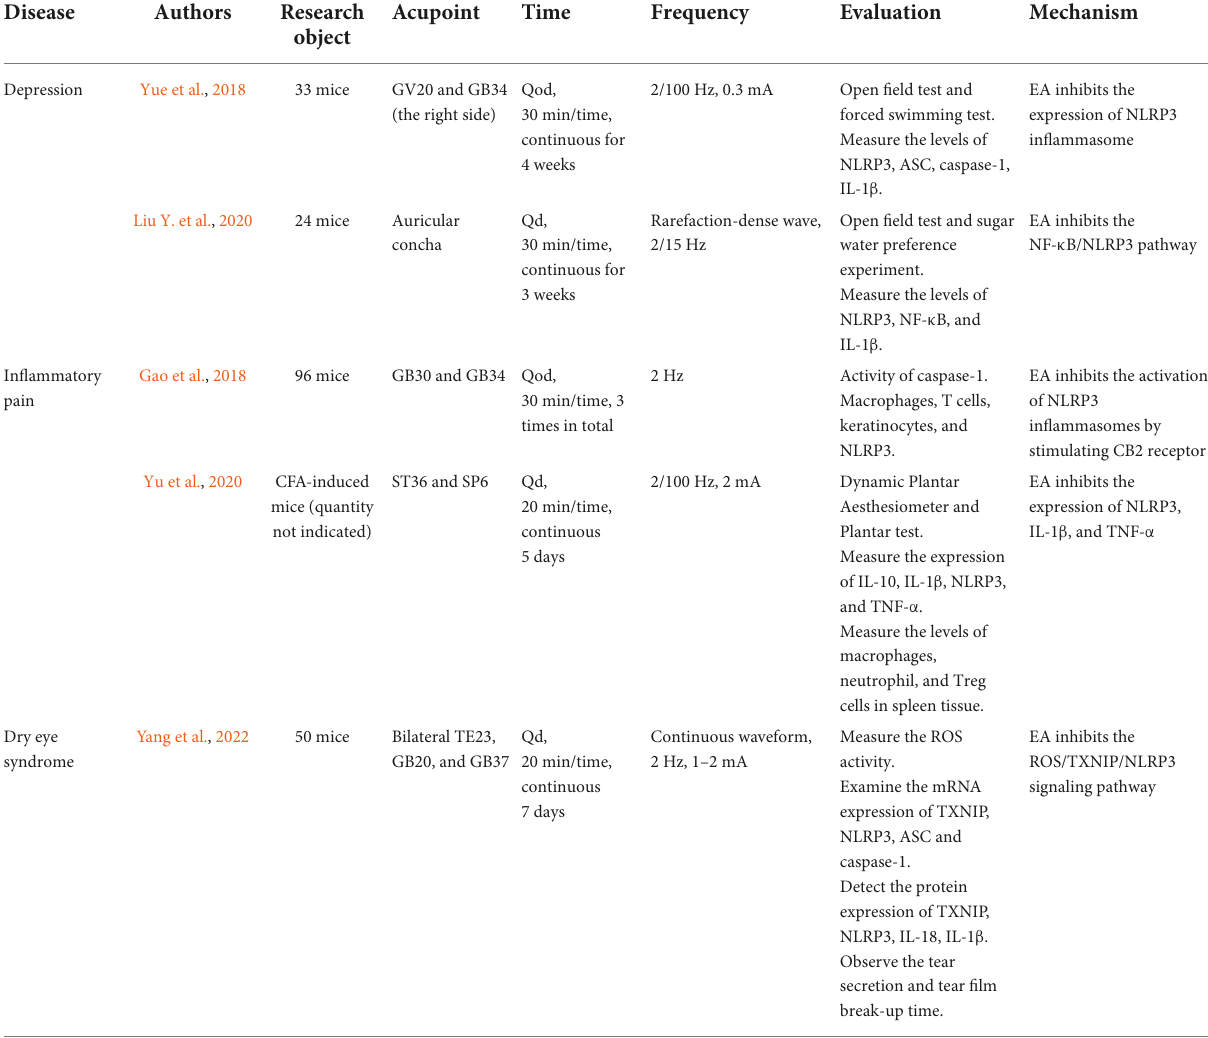
TABLE 6 Mechanism of electroacupuncture targeting NLRP3 inflammasome in the treatment of depression, inflammatory pain, and dry eye syndrome.